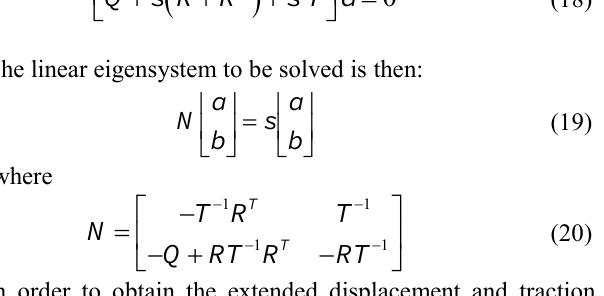
Figure 2: Sandwich multilayer made by piezo-magnetic matrix with Piezo-electric fiber volume fraction (VF) respectively of 0.1, 0.5 and 0.1